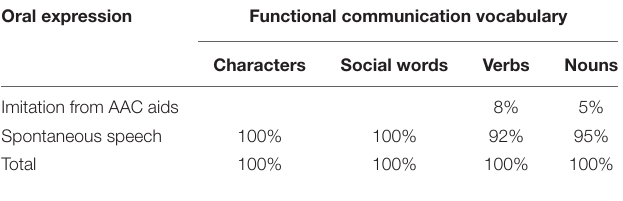
TABLE 5 | Oral expression following augmentative and alternative communication